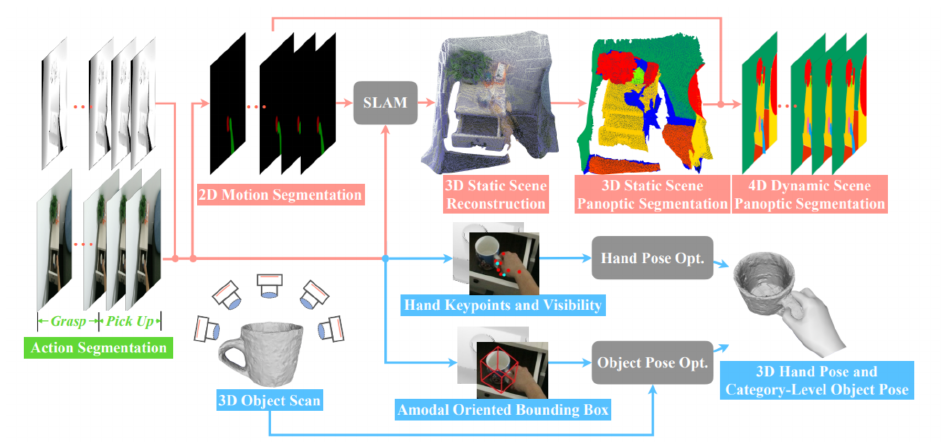
Figure 16. Describing the types of annotation data of the HOI4D dataset [8].